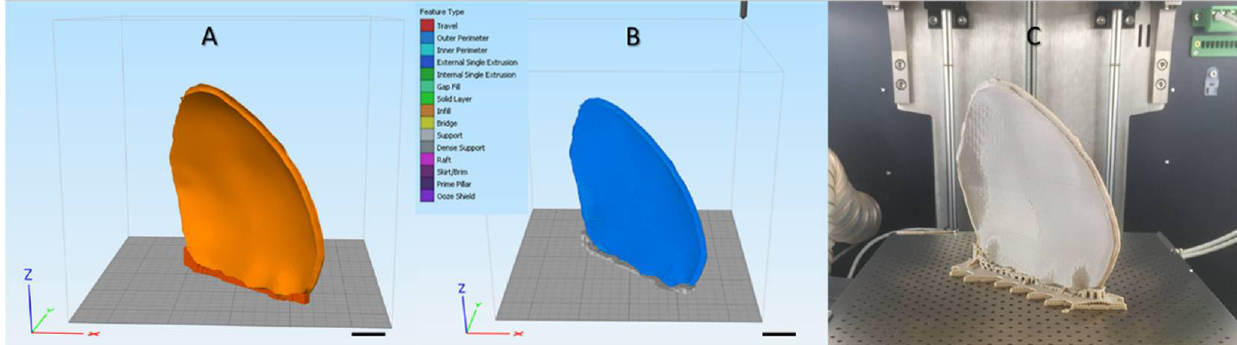
Figure 6. Schematic representation of the steps involved in the material extrusion fabrication process of PEEK patient- specific cranial implants: ( A ) Orientation of the implant in the slicing software on the printer’s build platform with support structures (scale bar, 1 cm) ( B ) G-code generation with the respective optimal printing parameters (scale bar, 1 cm); ( C ) Material extrusion 3D-printed PEEK cranial implant (in situ). Table 4. Printing parameters selected for the material extrusion 3D-printed PEEK patient-specific cranial implant.